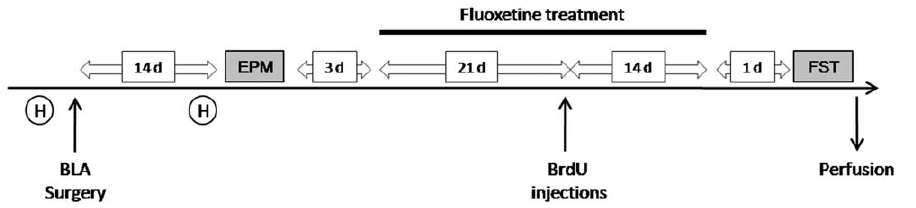
Figure 1. Schematic plan of experimental procedures and timetable. After handling (H), rats were submitted to stereotaxic surgery for BLA or sham lesions. After recovery, animals were handled again and levels of anxiety were characterized using the Elevated Plus Maze (EPM). Next, chronic fluoxetine treatment was initiated and BrdU was injected after twenty one days of drug administration. After interruption of fluoxetine treatment, depression-like behavior was evaluated using the Forced Swim Test (FST) and then